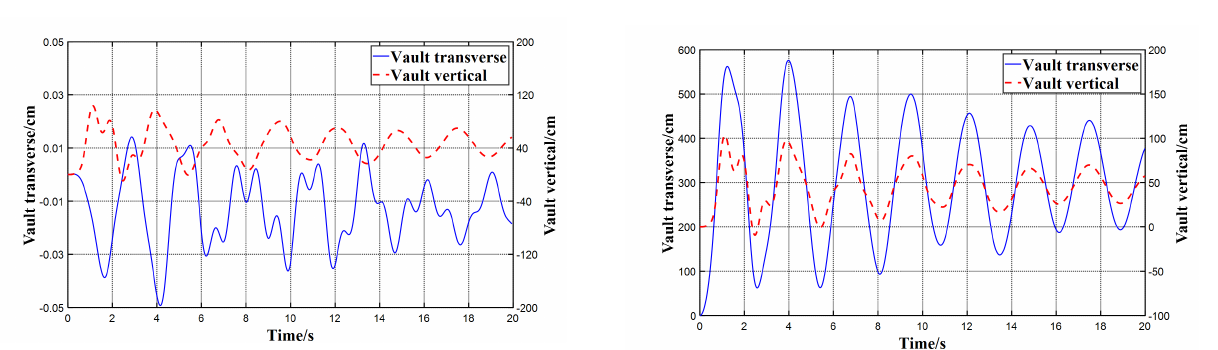
Fig. 13. Vault displacement under lateral seismic input